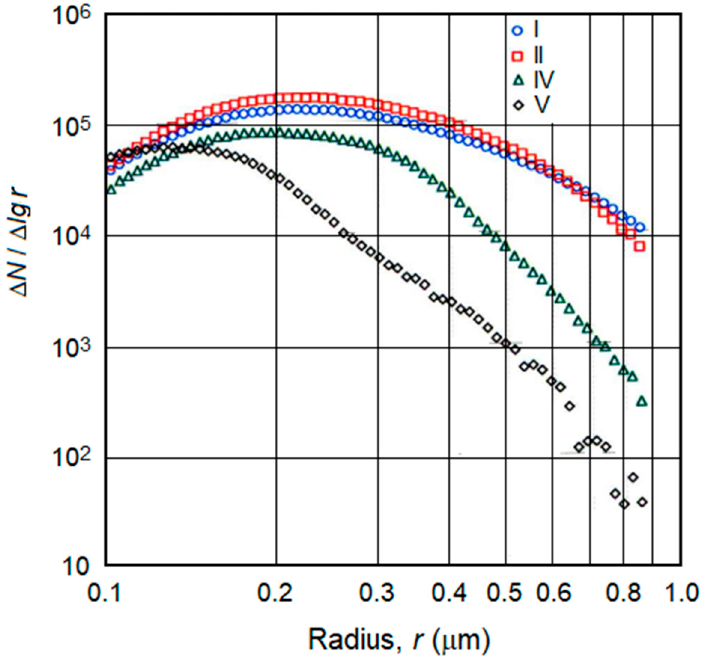
Figure 12. Aerosol Spectra of New Smoke Compositions.